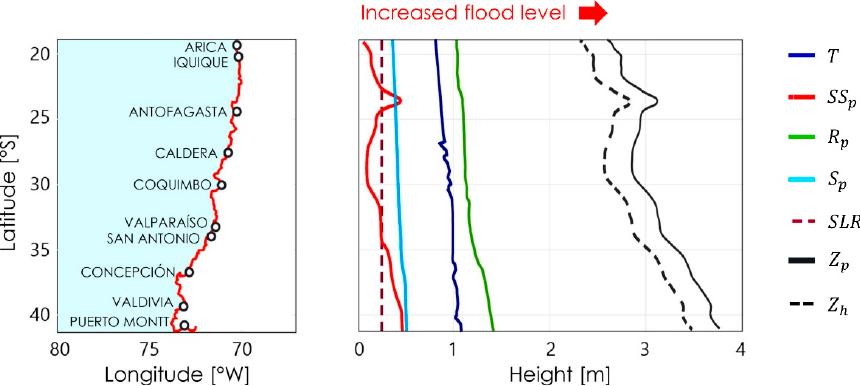
Figure 5. Estimation of the projected flooding hazard ( Z p ) for the RCP 8.5 scenario in the period 2026–2045, computed from the superposition of the maximum yearly astronomical tide ( T ), storm surge ( SS p ), wave setup ( S p ), wave runup ( R p ), wave swash ( S p ), and sea-level rise (SLR). The flooding hazard for the historical period 1985–2004 ( Z h ) is included. The data are computed at 0.1 ◦ intervals along the coastal region between Arica and Puerto Montt, where all 256 exposed settlements Water 2022 , 14 , x FOR PEER REVIEW were located. The places shown in the rightmost figure are for reference only.